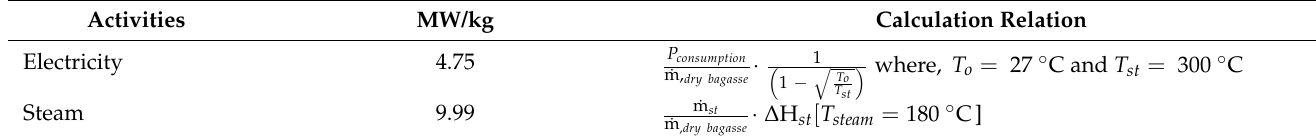
Table A1. Dry bagasse consumption to electricity generation and steam production (1 kg/s).